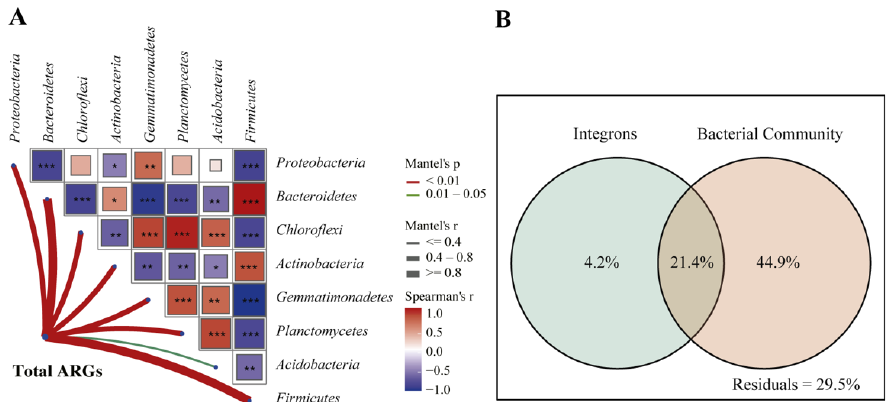
Figure 5. Drivers of the ARG profiles in the soil. ( A ) Mantel test between the entire ARG profiles and dominant bacterial community (>2% percentage). *, **, *** represent Spearman’s p < 0.05, p ≤ 0.01, and p ≤ 0.001, respectively. ( B ) VPA chart showing the effects of bacterial community and integrons on the shifts of soil resistomes.